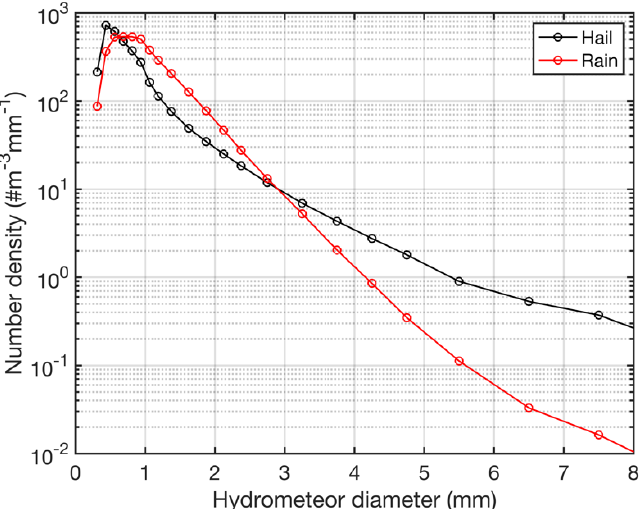
Figure 15. Mean droplet size distributions from the OTT Parsivel 2 disdrometer at US SGP condition- ally sampled for the presence of WC indicating hail and/or graupel and an equal number of liquid (rain only events) centered on the same mean RR as prevails during the hail/graupel events.